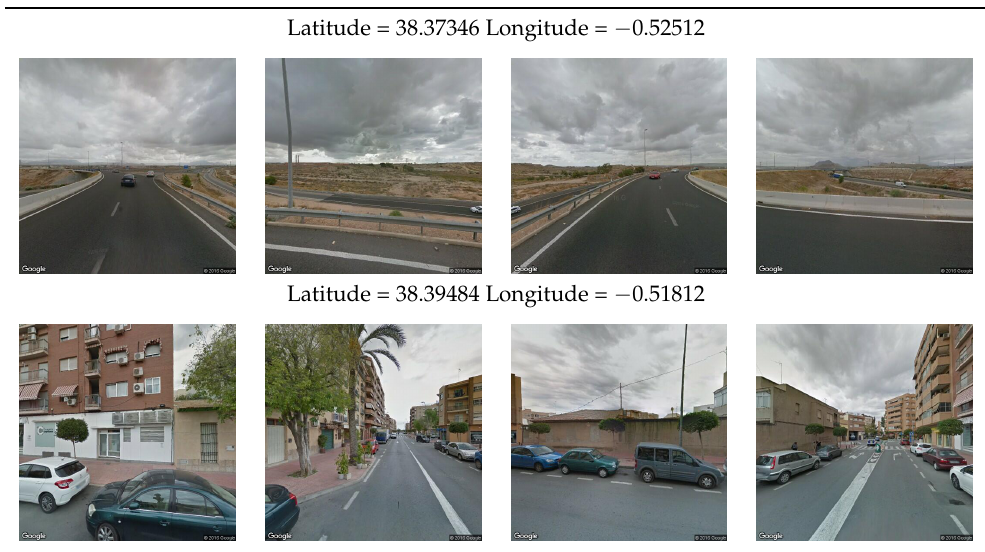
Table 3. Example images obtained with the Street View